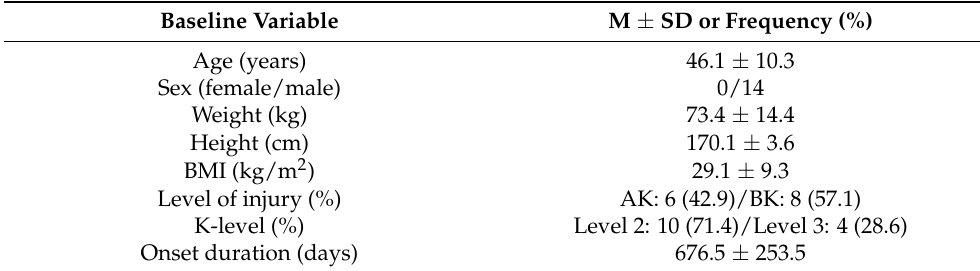
Table 2. General characteristics of the participants (n =